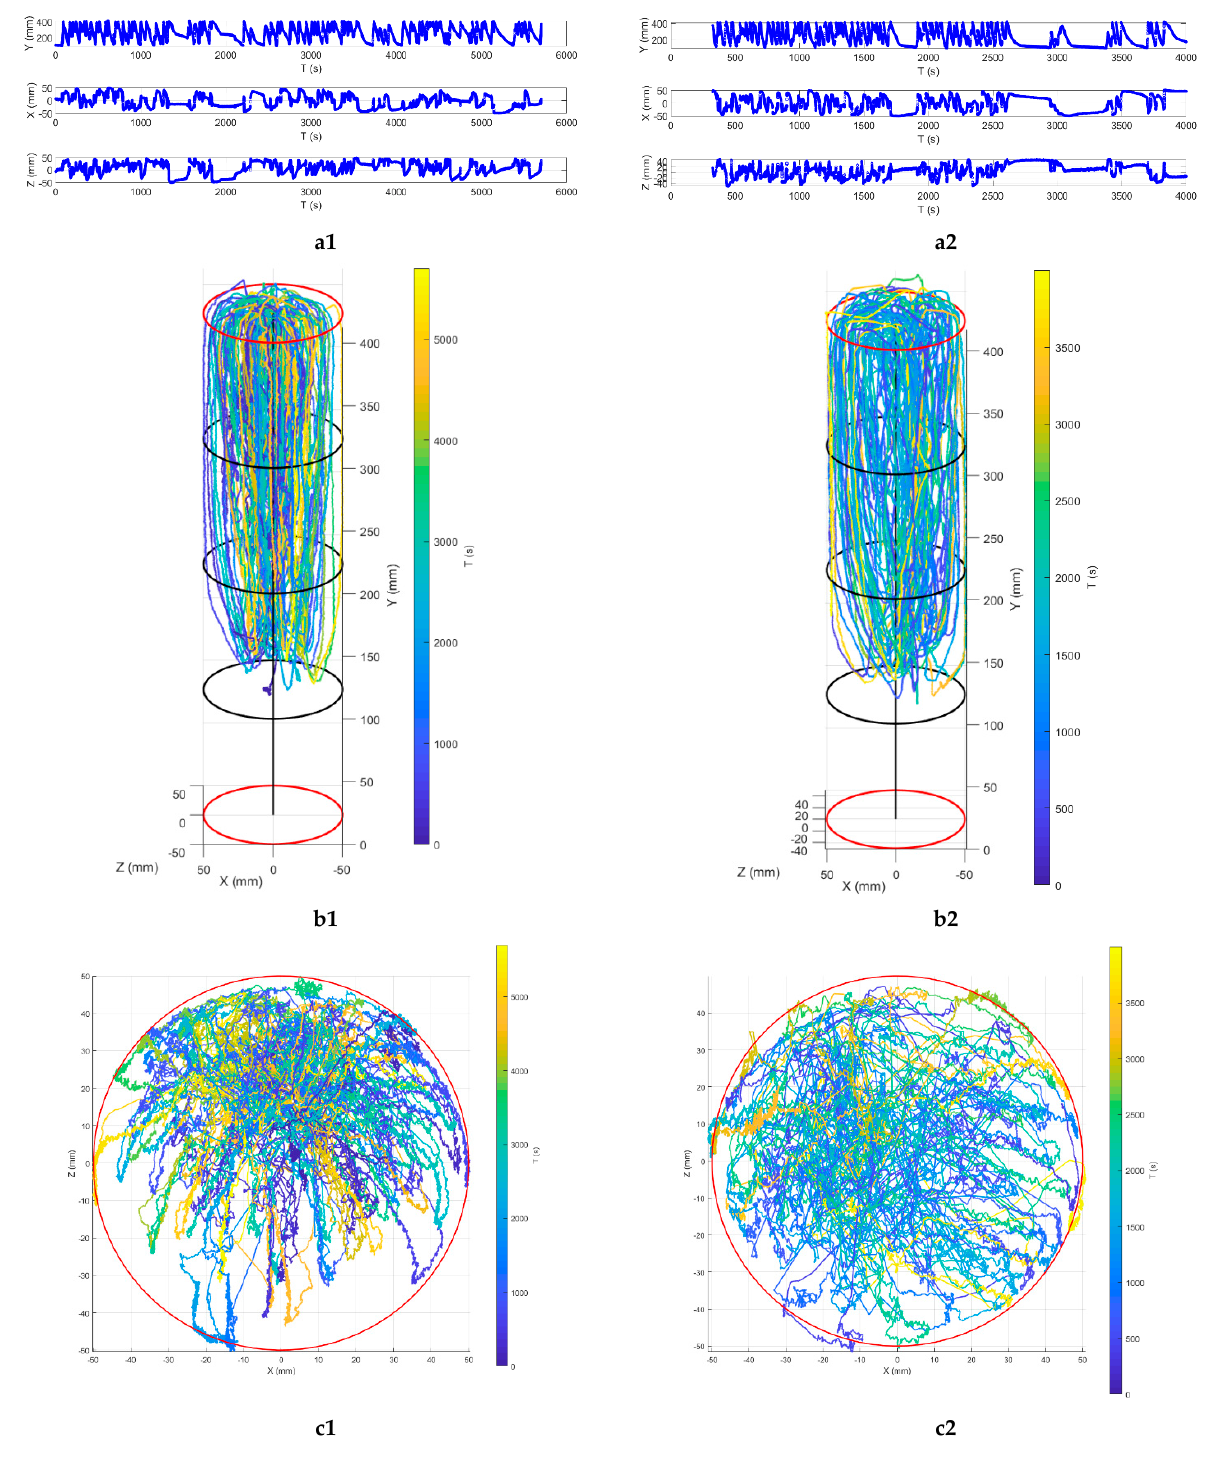
Figure A2. Trajectories of an activated quartz particle ( − 212 + 150 µm) inside the bed against time for 1.25 u mf (1) and 1.50 u mf (2): ( a ) the tracer trajectory with fit; the tracer trajectory from side view ( b ) and top view ( c ).